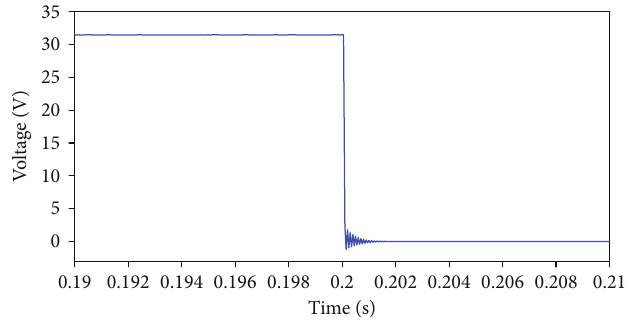
Figure 31: The output voltage of PV1, when the MOSFET of converter 1 fails.